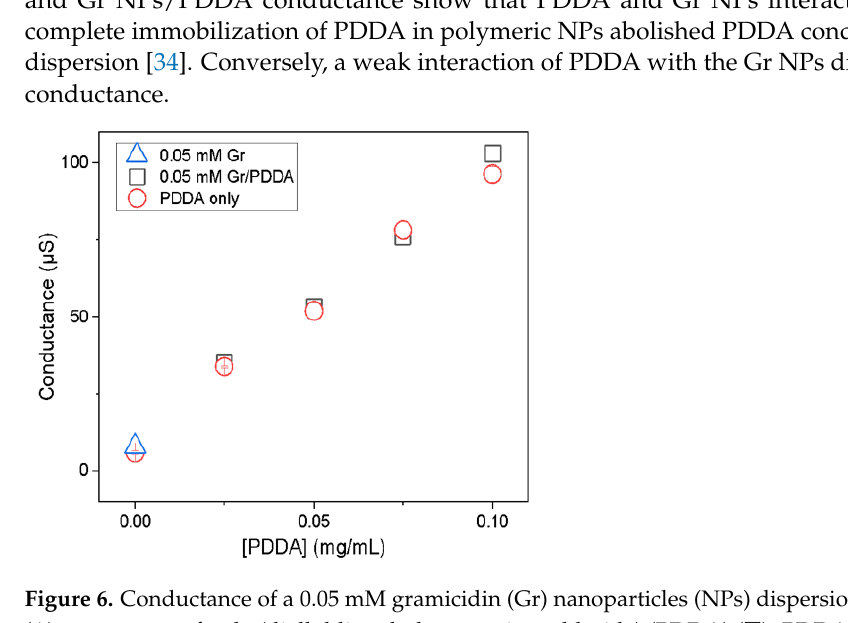
nium chloride) (PDDA) stock solution (10 mg/mL) were added to Gr dispersion under stirring by